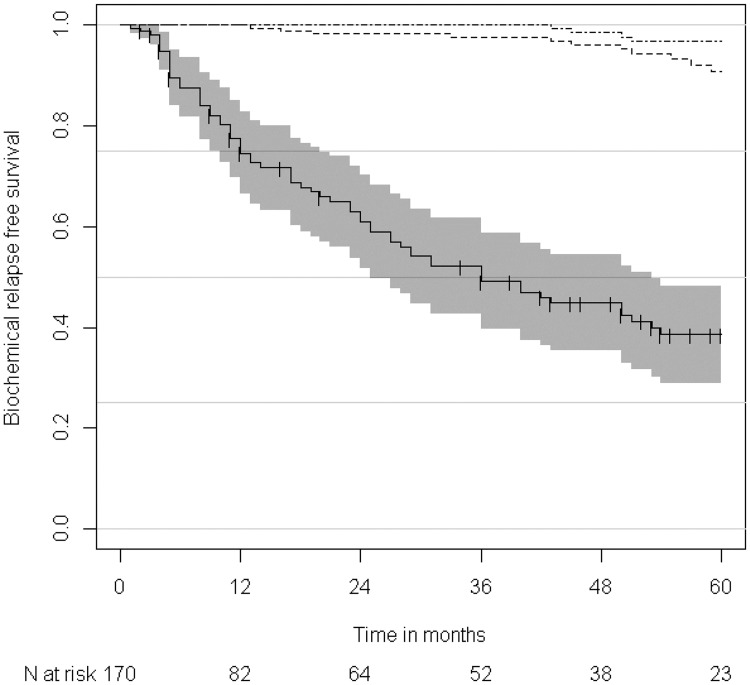
Kaplan–Meier estimates of biochemical progression-free survival (BCPFS, Solid line), overall survial (OS, Long dashed line), and cause-specific survival (CSS, Dash-dotted line).Number at risk for biochemical progression-free survival is indicated.